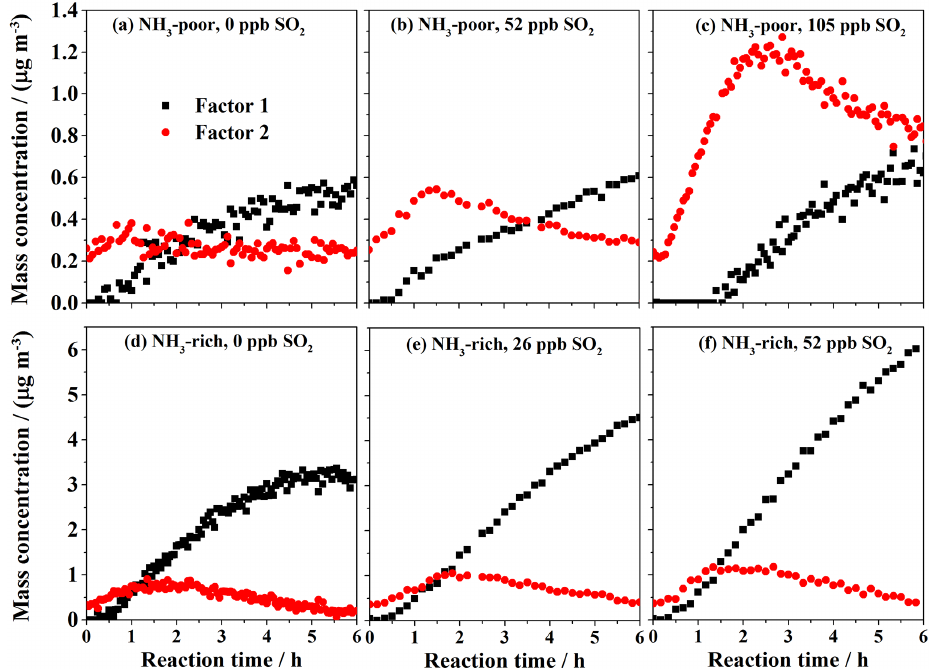
Figure 8. Temporal variations of Factor 1 and Factor 2 in the presence of different concentrations of SO 2 under NH 3 -poor and NH 3 -rich conditions.